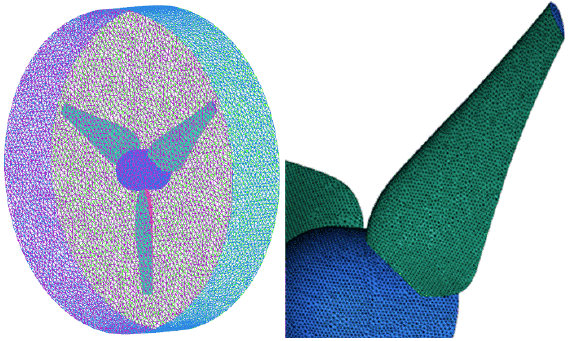
Figure 6. Grid model.